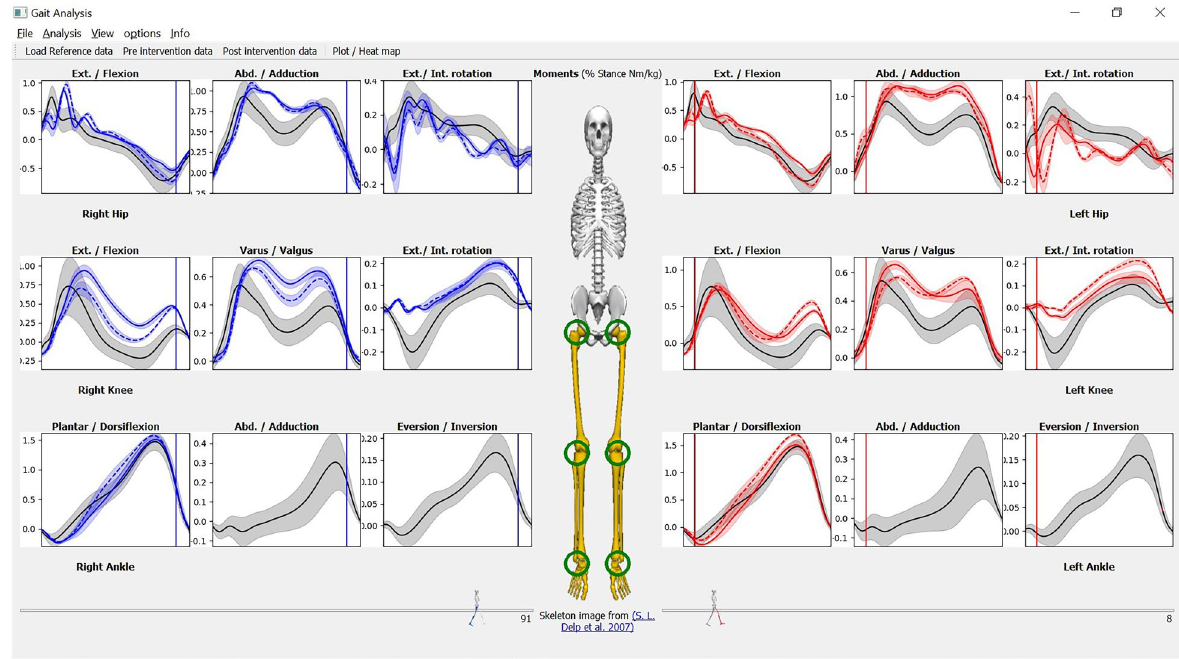
Figure 2. MovementRx after loading the reference, pre and post intervention data. The black line is the reference, the solid color line is the preintervention data, while the dashed line is the post intervention data. The pre and post intervention data are colored blue for the right limb and red for the left limb. The same color code applies for the animated walking men below and related indicator in the panels. This recording does not have ankle values for both Y (adduction/abduction) and Z (inversion/eversion) dimensions due to the use of a simplistic model not designed for 3D ankle mechanics.